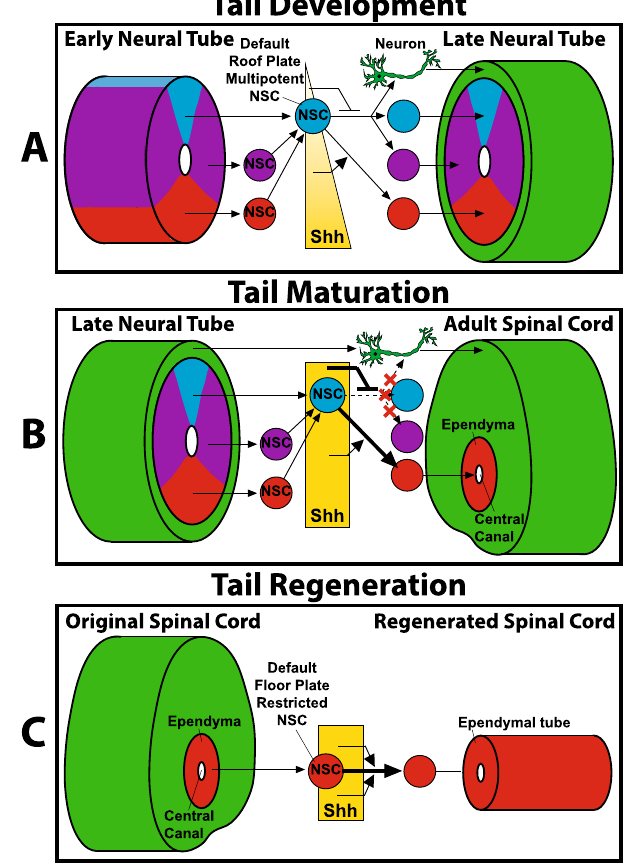
Fig. 5 Summary of divergent NSC identities and differentiation capabilities exhibited during lizard tail development, maturation, and regeneration. A Roof, lateral, and fl oor plate domains of embryonic neural tubes harbor multipotent NSCs that default to a roof plate identity during culture in vitro. Shh speci fi cally produced by neural tube fl oor plates establishes Hedgehog signaling gradients that in fl uence embryonic NSC differentiation and neurogenesis. During tail development, neural tube NSCs ventralize and form neurons according to hedgehog gradients. B During tail maturation, embryonic neural tubes give rise to adult spinal cords, and remnant NSC populations persist in ependymal linings of central canals. Hedgehog gradients breaks down, inhibiting roof and lateral domain differentiation, and adult NSCs exhibit fl oor plate identities only. C Regenerated tail spinal cords consist of ependymal tubes made up of NSCs derived from original tail ependyma. Because adult NSCs are incapable of roof/lateral domain differentiation and neurogenesis, ependymal tube NSCs are restricted to fl oor plate identities, and no new spinal cords neurons are formed during tail regrowth. Adult NSCs retain fl oor plate identities in vivo and in vitro regardless of Hedgehog singling, resulting in unregulated Shh expression and lack of Hedgehog-induced tissue patterning in regenerated